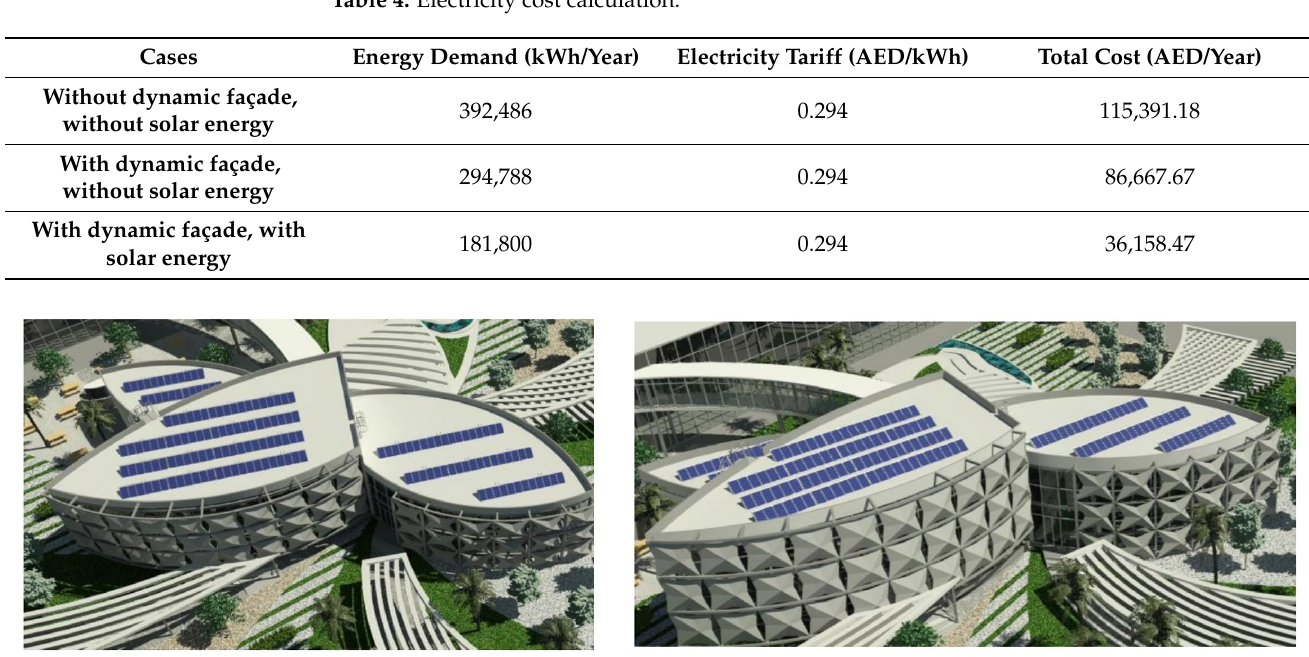
Figure 30. Rooftop images of the applied PV.